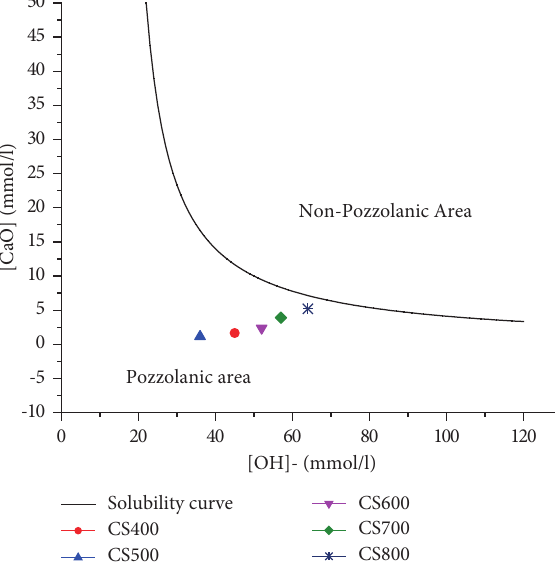
Figure 8: Fratini solubility cure for corn stalk ash